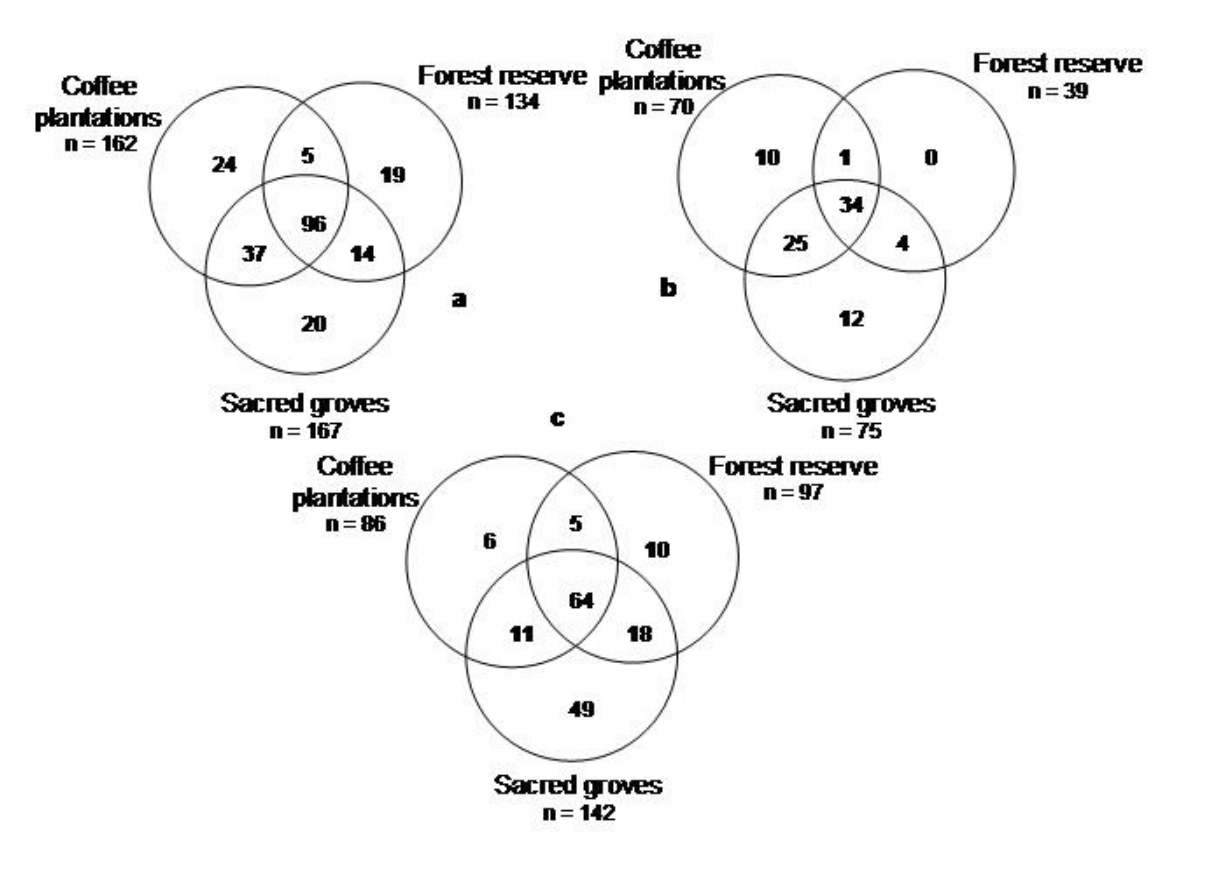
Fig. 4. Numbers of restricted and shared species of a) trees, b) birds, and c) macrofungi in Kodagu, Western Ghats of